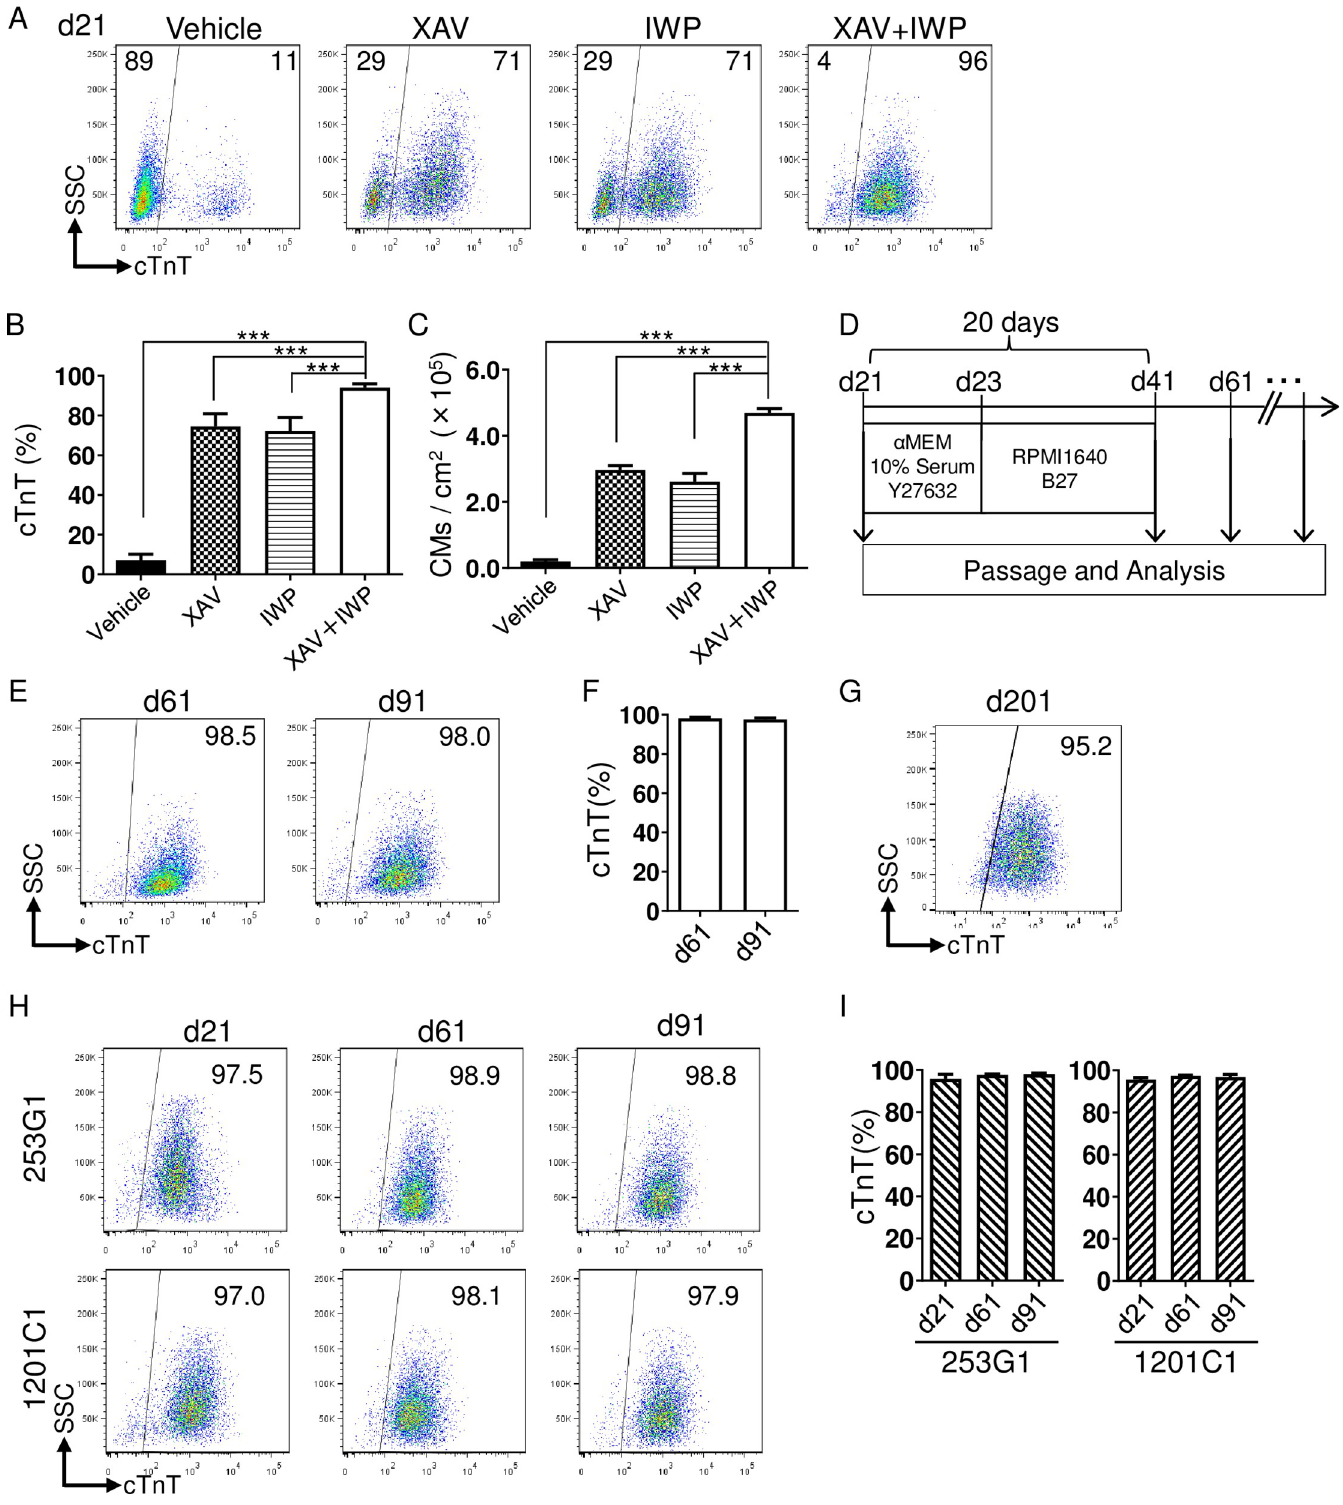
Fig 2. Induction and maintenance of hiPSC-derived CMs with high-purity. (A) Representative flow cytometry analysis of cTnT (and side scatter plot (SSC)) on d21 induced by combinations of Wnt signal inhibitors (XAV939 and IWP4). The percentages of cTnT + and cTnT - cells are indicated. (B) Quantitative analysis of cTnT + CMs on d21. Data are means ± SD. ��� p < 0.001 by one-way ANOVA followed by Tukey-Kramer post hoc test (n = 4). (C) CM yield on d21. Data are means ± SD.